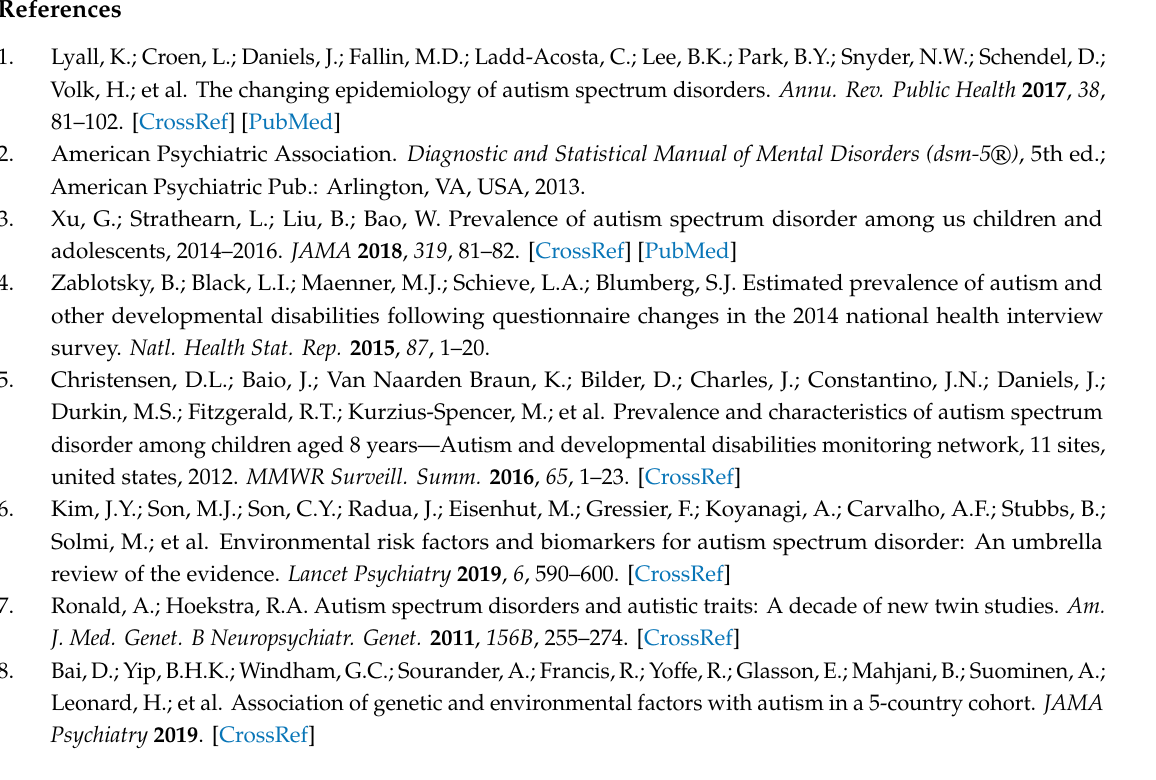
Supplementary Table S1. PRISMA 2009 Checklist; Supplementary Table S2. Gene variants without statistical significance ( p -value ≥ 0.05) in meta-analyses of observational studies; Supplementary Table S3. Non-re-analyzable gene variants with genome wide statistical significance ( p -value < 5 × 10 − 8 ) from the GWAS catalog, meta-analyses of GWAS and the GWAS datasets included in the GWAS